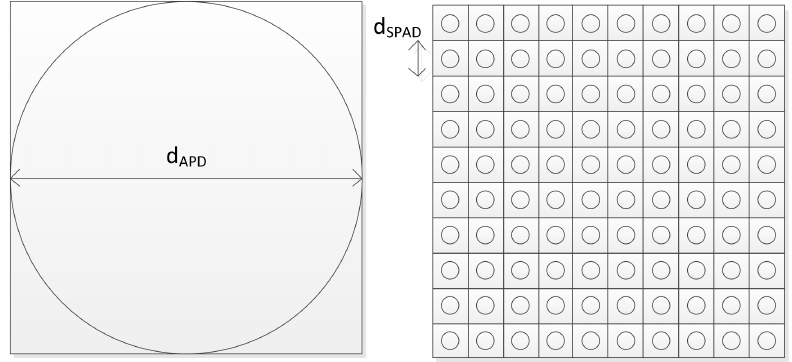
Figure 5. Comparison case for a single pixel APD detector of diameter 500 µ m and a SPAD detector with 100 pixels and respective diameter of 50 µ